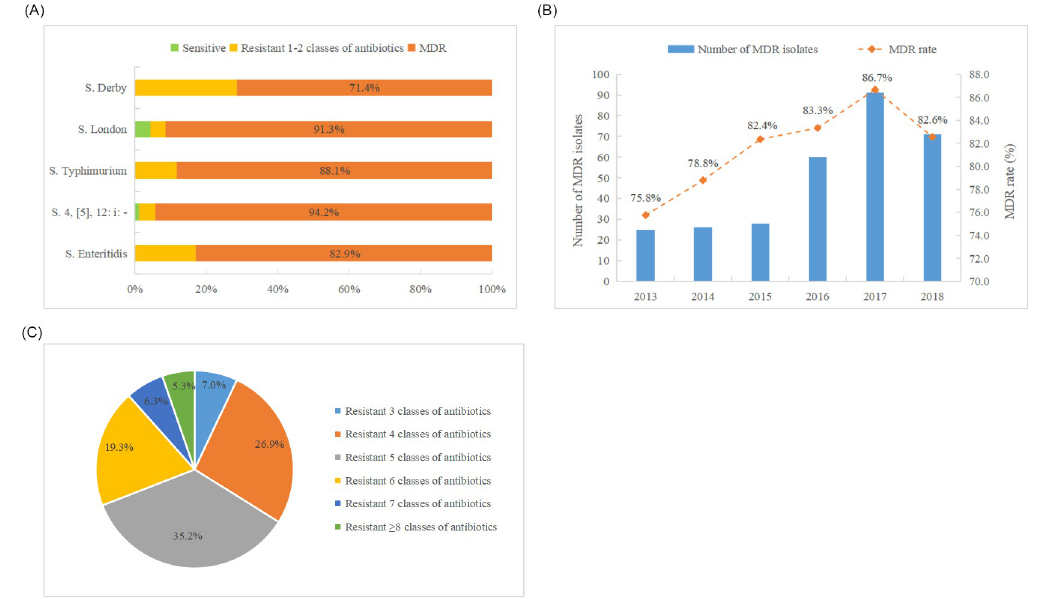
Fig 2. (A) MDR of the top five serotypes of Salmonella isolates in Guizhou, (B) MDR rates of Salmonella isolates in Guizhou from 2013 to 2018, (C) Resistant to � three classes of antibiotics for Salmonella isolates in Guizhou from 2013 to 2018.